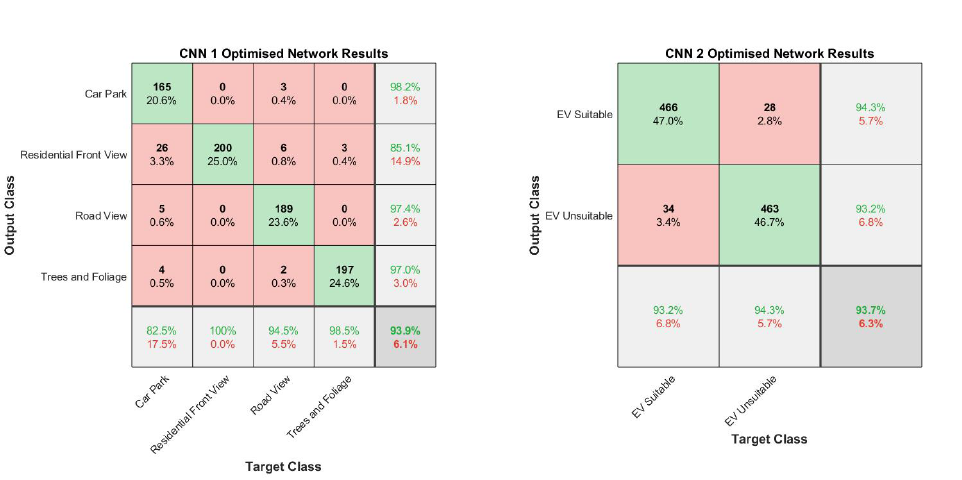
Figure 5. Confusion matrices from the best performing networks following the grid search optimisa- tion for CNN 1 ( Left ) and CNN 2 ( Right